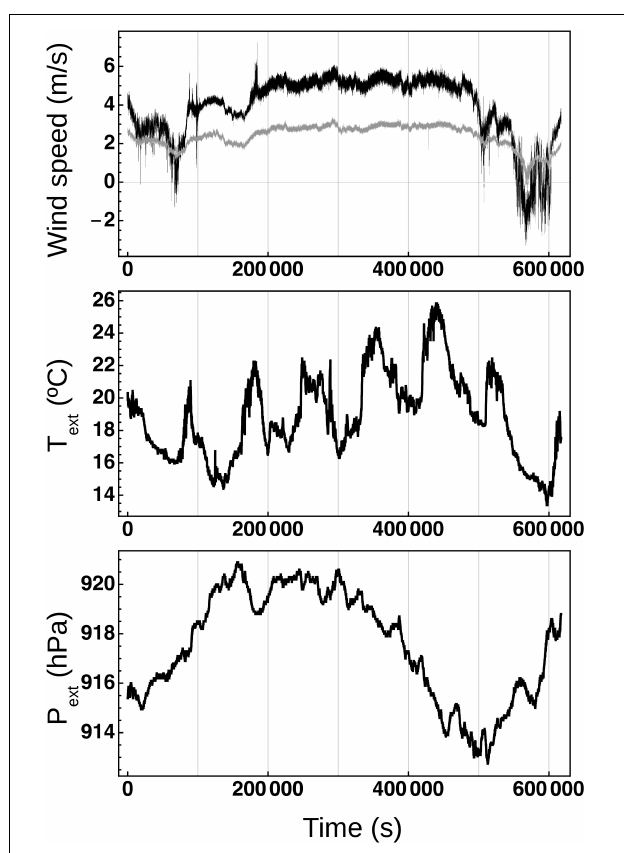
FIGURE 1 | Wind speed and external temperature and pressure measured synchronously at the Eolo and Serpente entrances of the Antro del Corchia cave. Top, raw wind speed data recorded (0.2 Hz sampling rate) at the two entrances. Middle, external temperature. Bottom, external